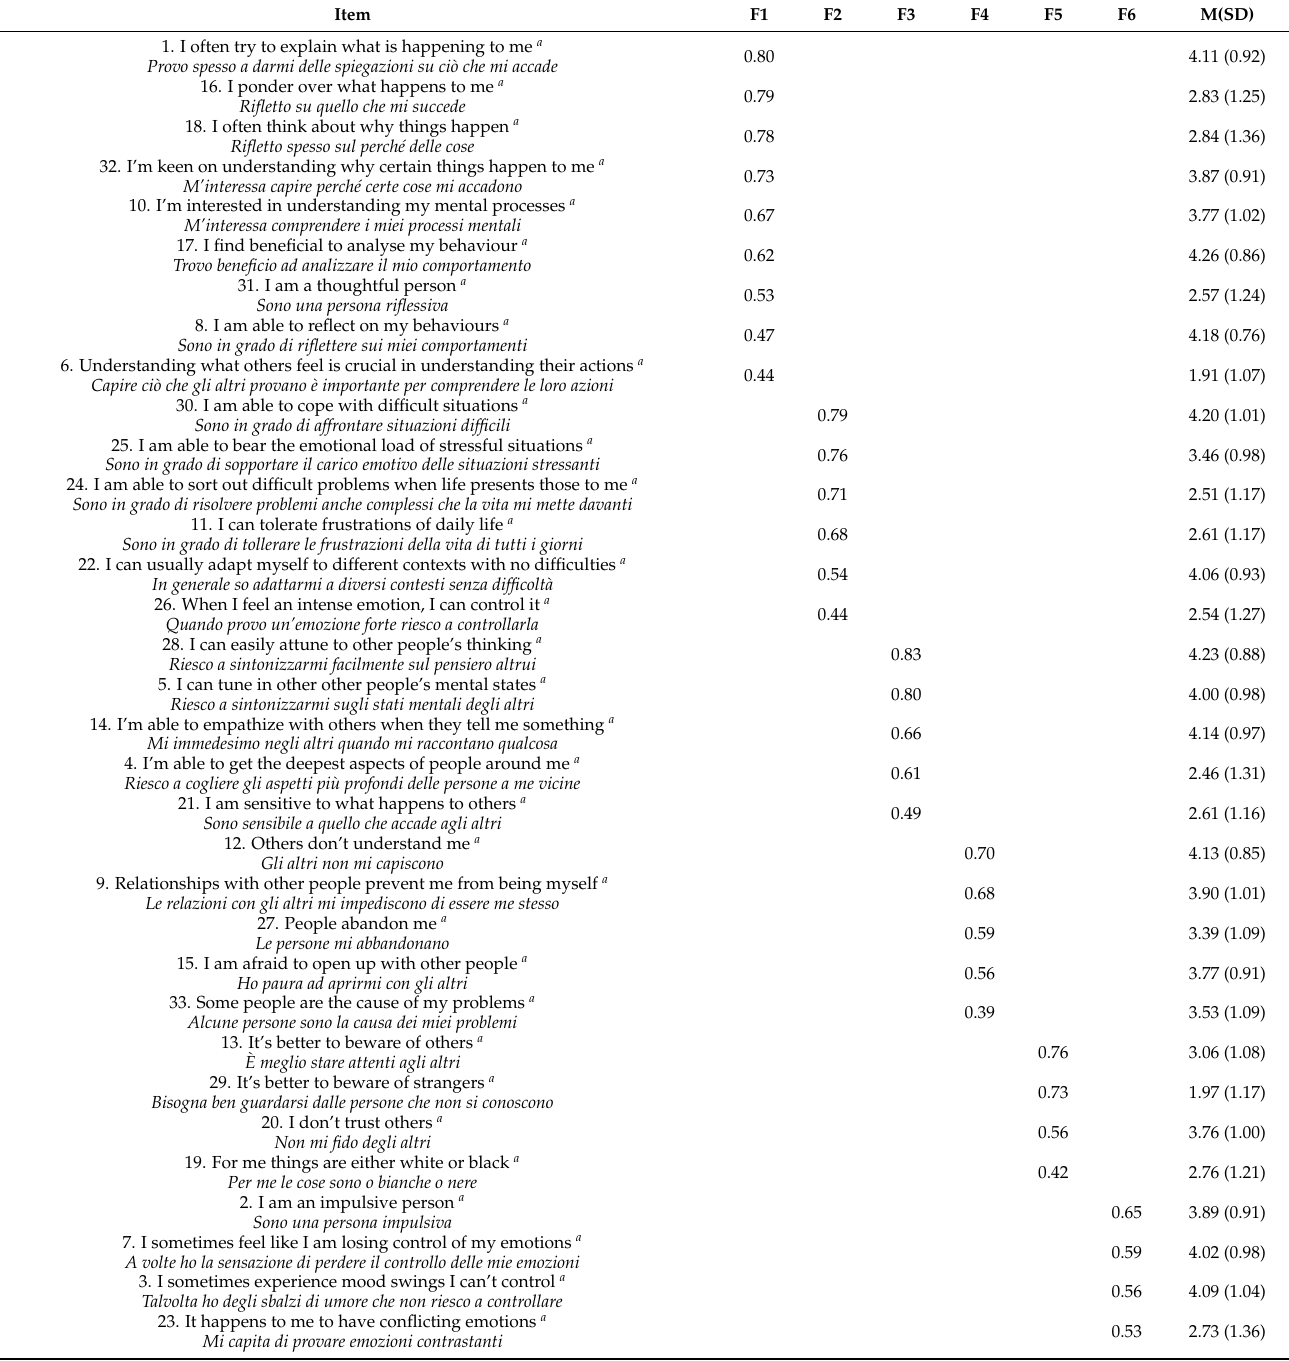
Table 2. Factor structure of the Multidimensional Mentalizing Questionnaire and means and standard deviations of the